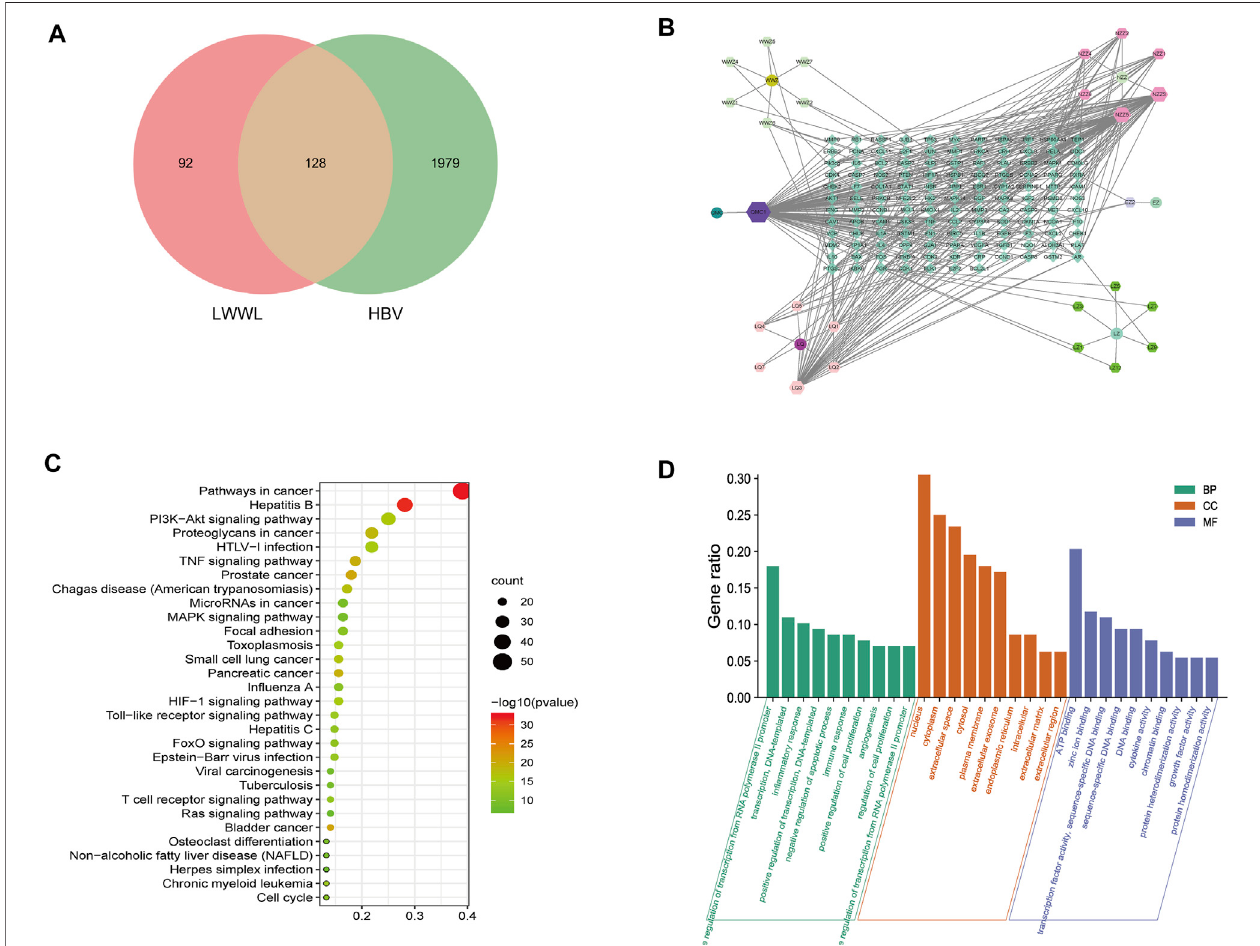
FIGURE7| AnalysesofactivecompoundsandpathwaysofLWWLagainstHBVbasedonnetworkpharmacology. (A) VeendiagramoftargetsinLWWLandHBV. (B) The LWWL-Compounds-Target-HBV network. Green diamond represents 128 putative targets of LWWL for the treatment of HBV. Cycle represents six herbs of LWWL including WWZ (Schisandrae chinensis fructus), NZZ (Ligustri lucidi fructus), EZ (Curcumae rhizoma), LQ (Forsythiae fructus), JMC (Field Sowthistle Herb), LZ (Ganodermaspore).Hexagonaroundcyclerepresents26activecompoundsofLWWL,and Table1 fordetails. (C) TheGOanalysisof128targetsofLWWLforthe treatment of HBV. (D) The KEGG analysis of 128 targets of LWWL for the treatment of HBV. LWWL, Liuweiwuling Tablet. KEGG, Kyoto Encyclopedia of Genes and Genomes database; GO, gene ontology.